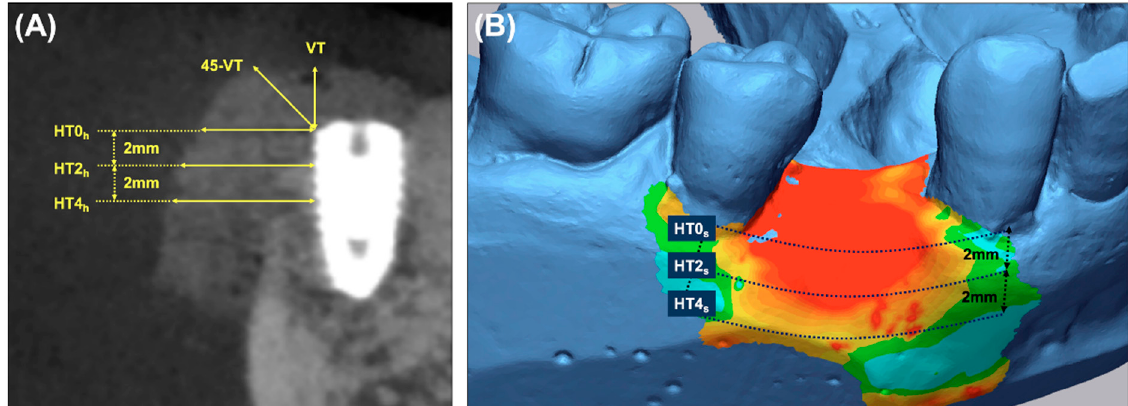
Figure 3. Schematic diagram of radiographic and volumetric outcome measurement. ( A ) Measure the horizontal and ver- tical thickness of the augmented hard tissue using sagittal CBCT images. HT0h, 2h, and 4h: Horizontal thicknesses at 0, 2, and 4 mm apically below the implant fixture shoulder; VT and 45-VT: Vertical thickness following the long axis of the fixture shoulder and positive 45° relative to the long axis of the fixture shoulder. ( B ) The horizontal thickness of the aug- mented soft tissue determined using stereolithography. HT0s, 2s, and 4s: the region of interest was limited by the mid-point of the facial cementoenamel junction of the mesial and distal teeth and extended 0, 2, and 4 mm apically below the buccal crest.